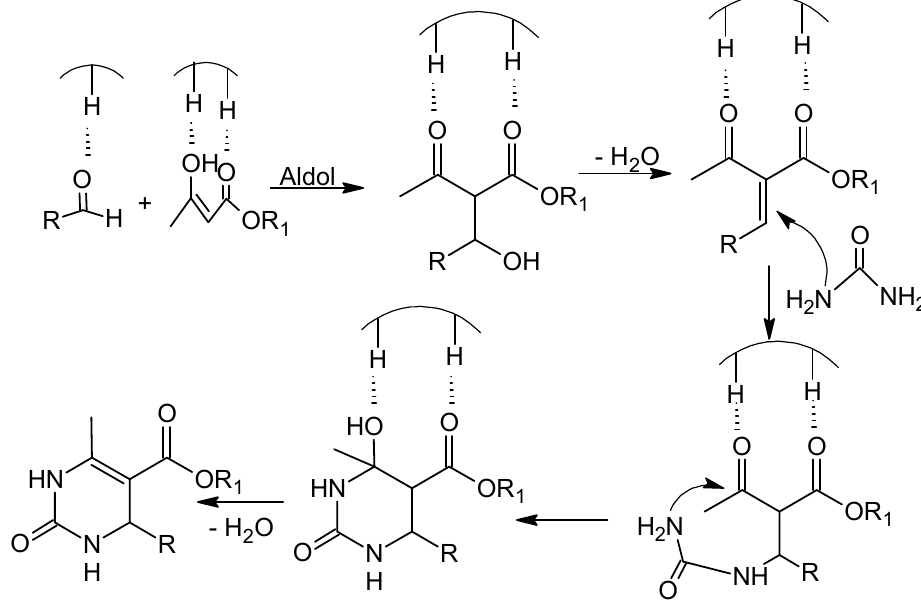
Scheme 5. Mechanism of the enzyme-catalyzed Biginelli reaction.